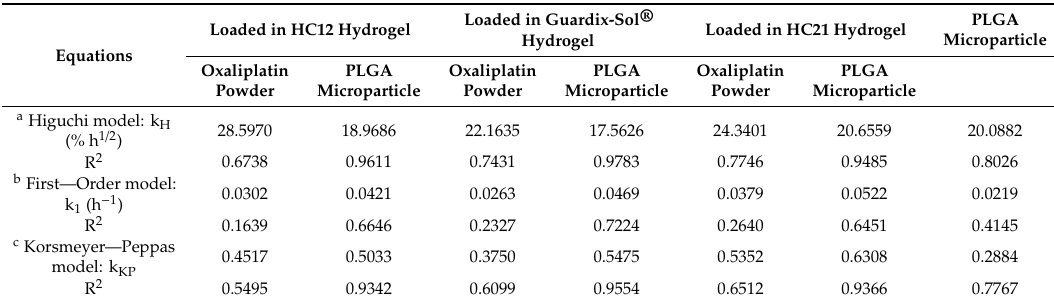
Table 2. Release rate constants and regression coefficient R 2 obtained from drug release profile based on kinetic equations.